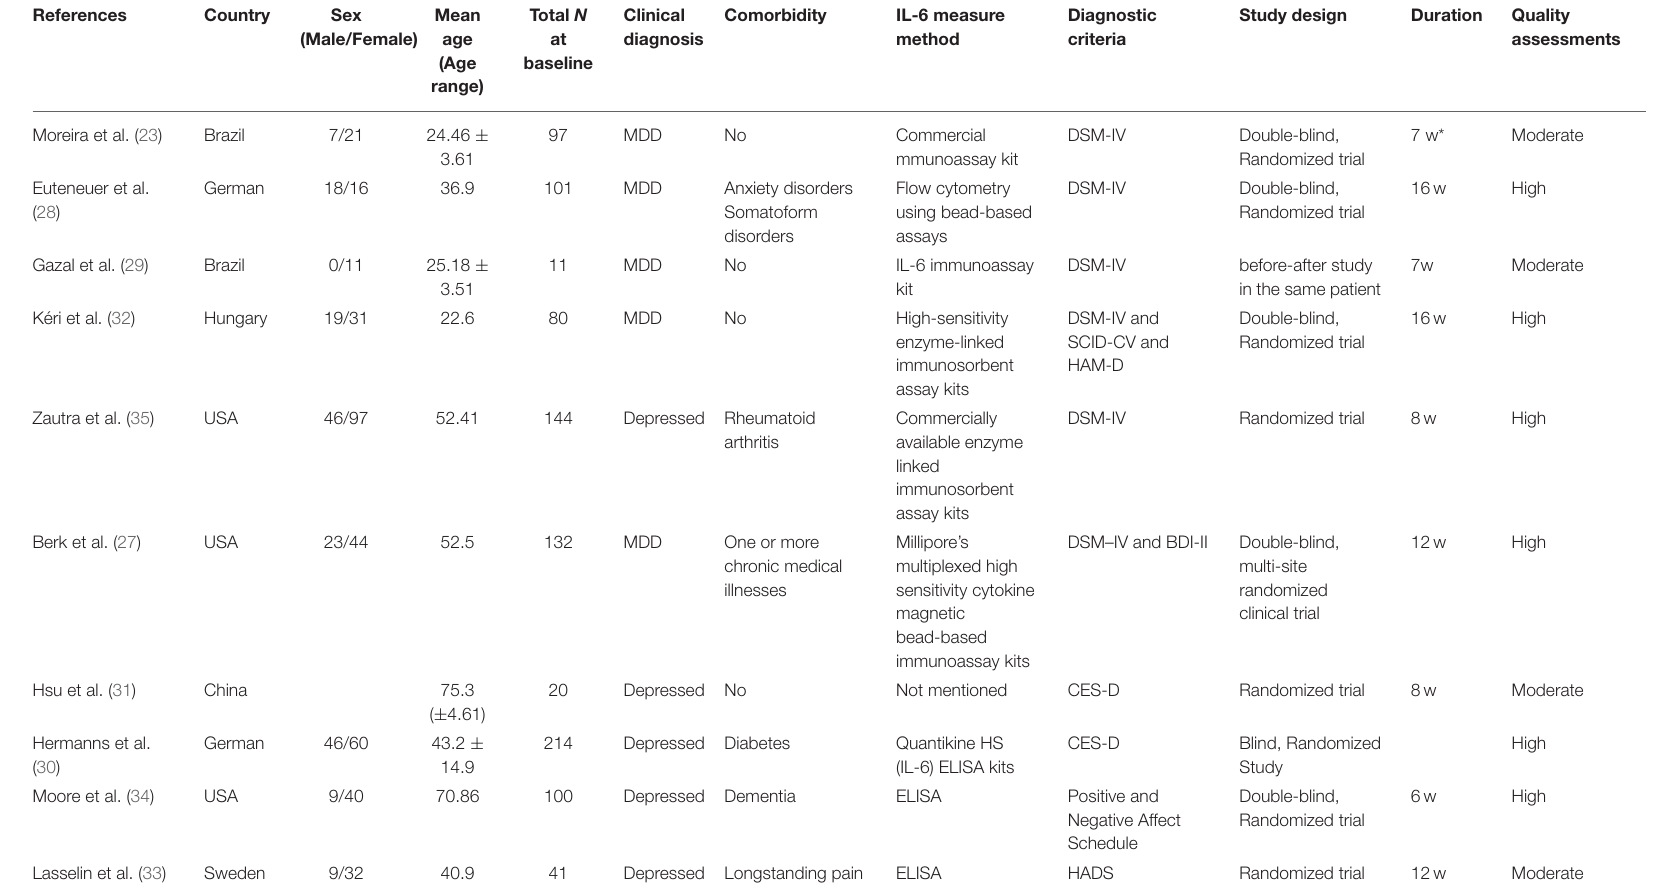
TABLE 1 | Characteristics of included